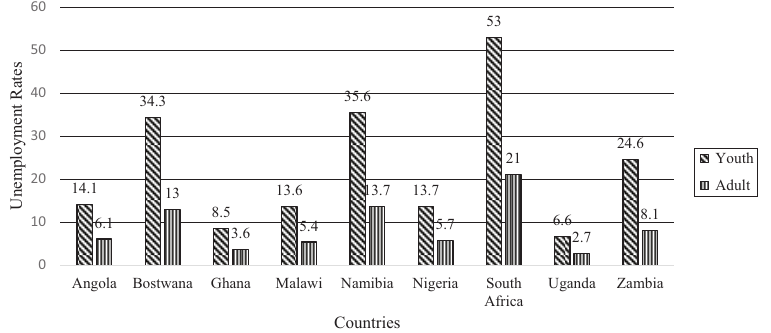
Figure 2. Unemployment rates